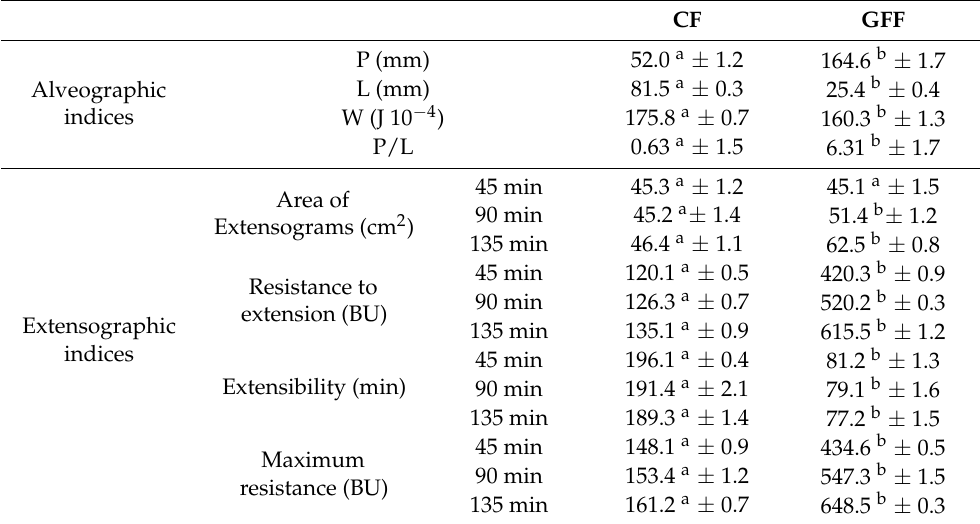
Table 3. Alveograph and extensograph evaluation of control flour (CF) and Gluten Friendly™ flour (GFF) 1 .